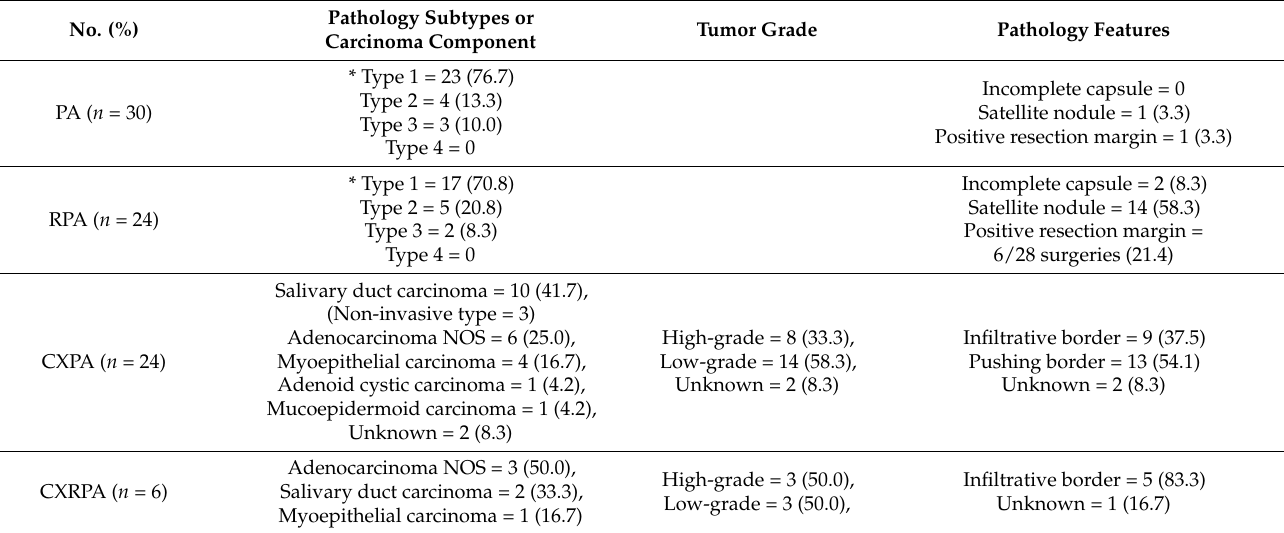
Table 2. Pathological tumor subtypes.